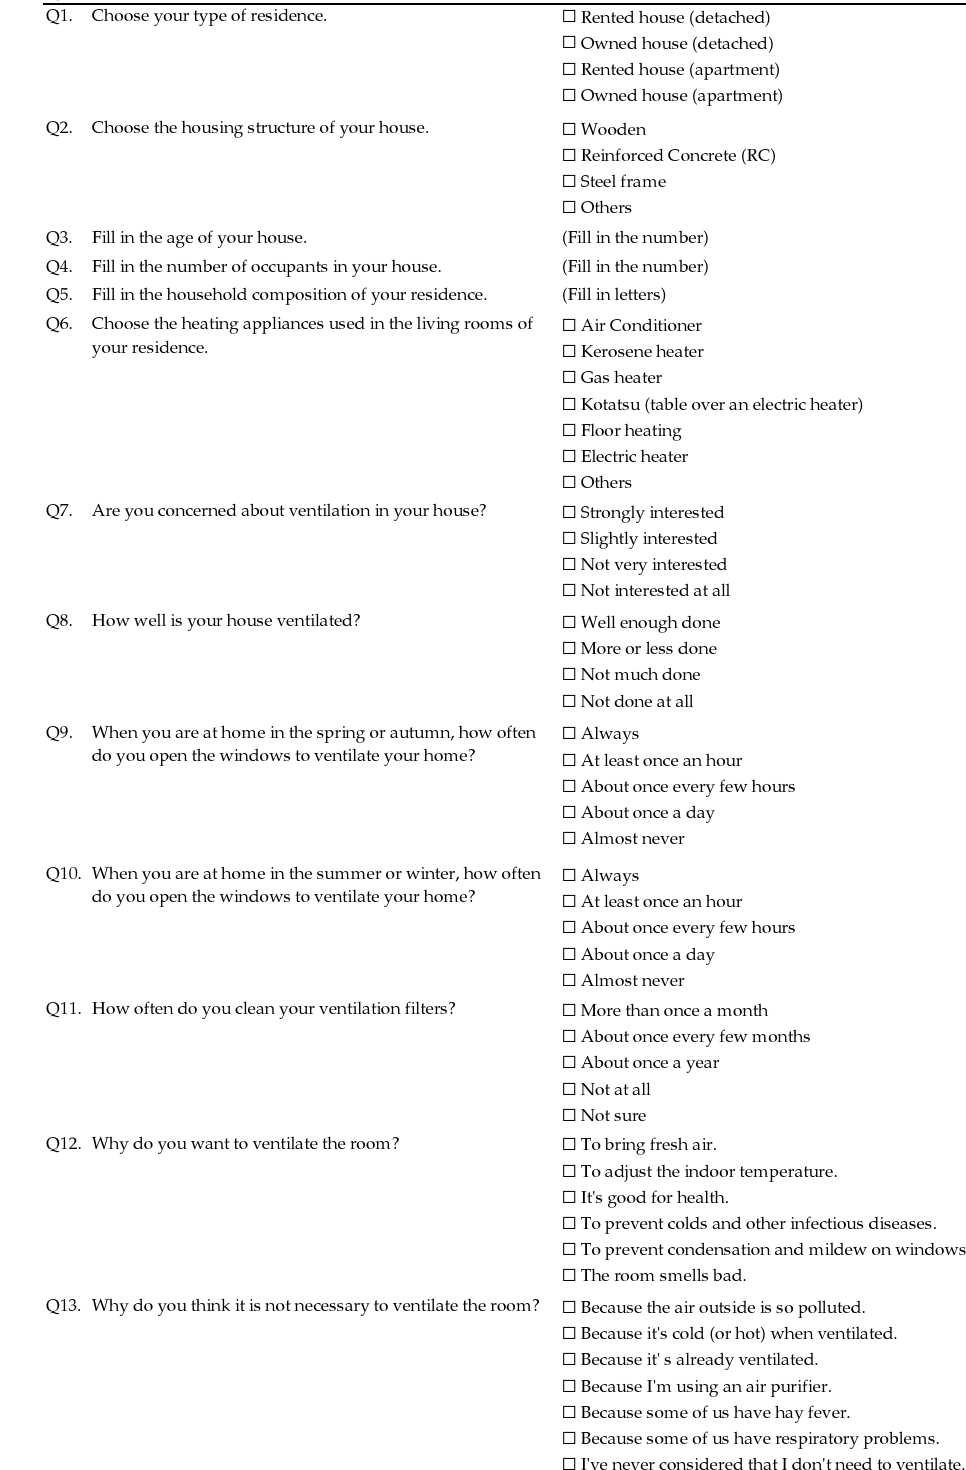
Figure A1. Questionnaire survey regarding housing attribute, their awareness and behavior of